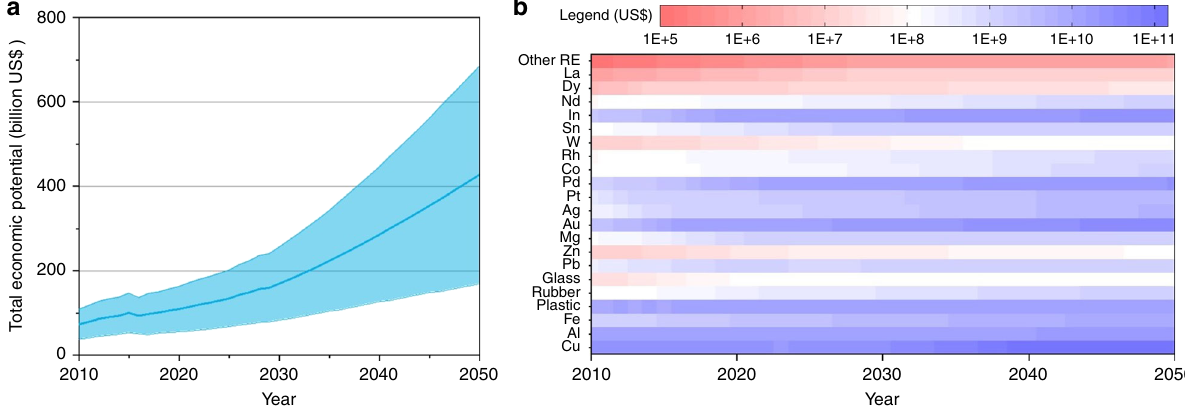
Fig. 4 Economic potential of AM. a economic value of total annual AM. b economic potential map of materials. Note: the shade of light blue indicates the range of recycling potential. RE, rare